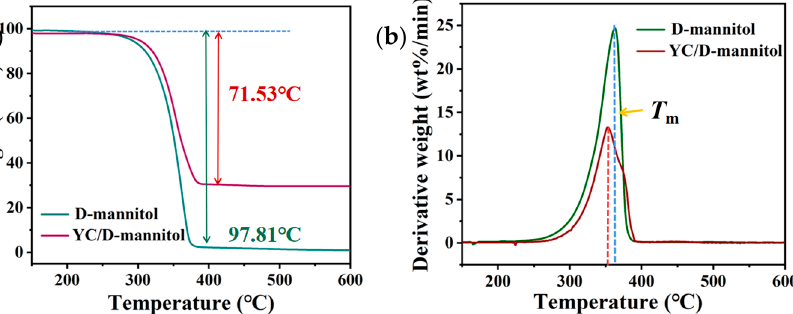
Figure 7. ( a ) TGA and ( b ) DTG thermograms of the pure D-mannitol and the YC/D-mannitol ss-